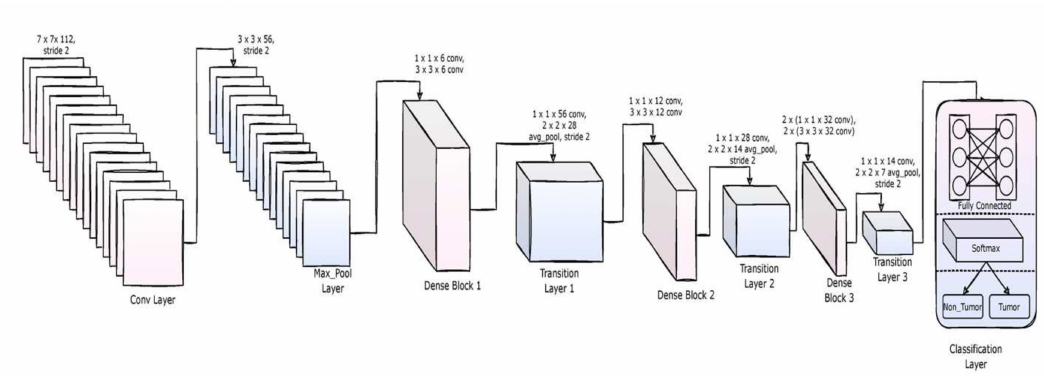
Figure 5. The architecture of DenseNet-169 used to implement the proposed